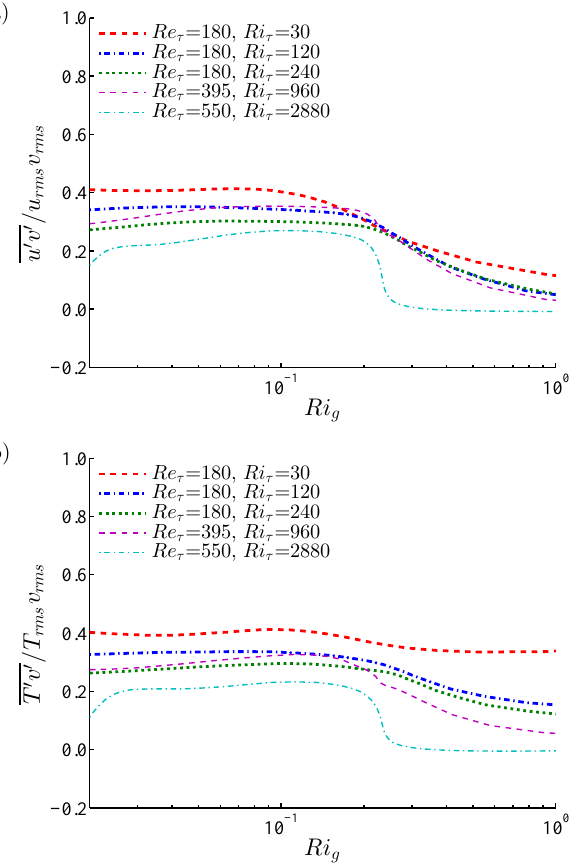
Figure 16. Distribution of Ri g with respect to correlation coefficient of (a) momentum and (b) heat